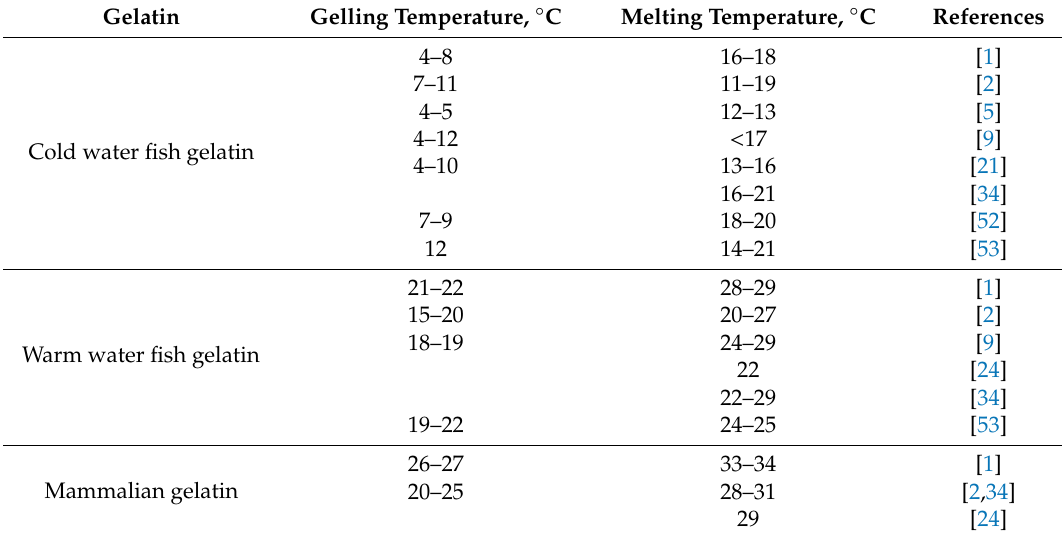
Table 2. Gelling and melting temperatures of cold and warm water fish gelatin gels compared to mammalian gelatin gels for 6.67–10% ( w / v )